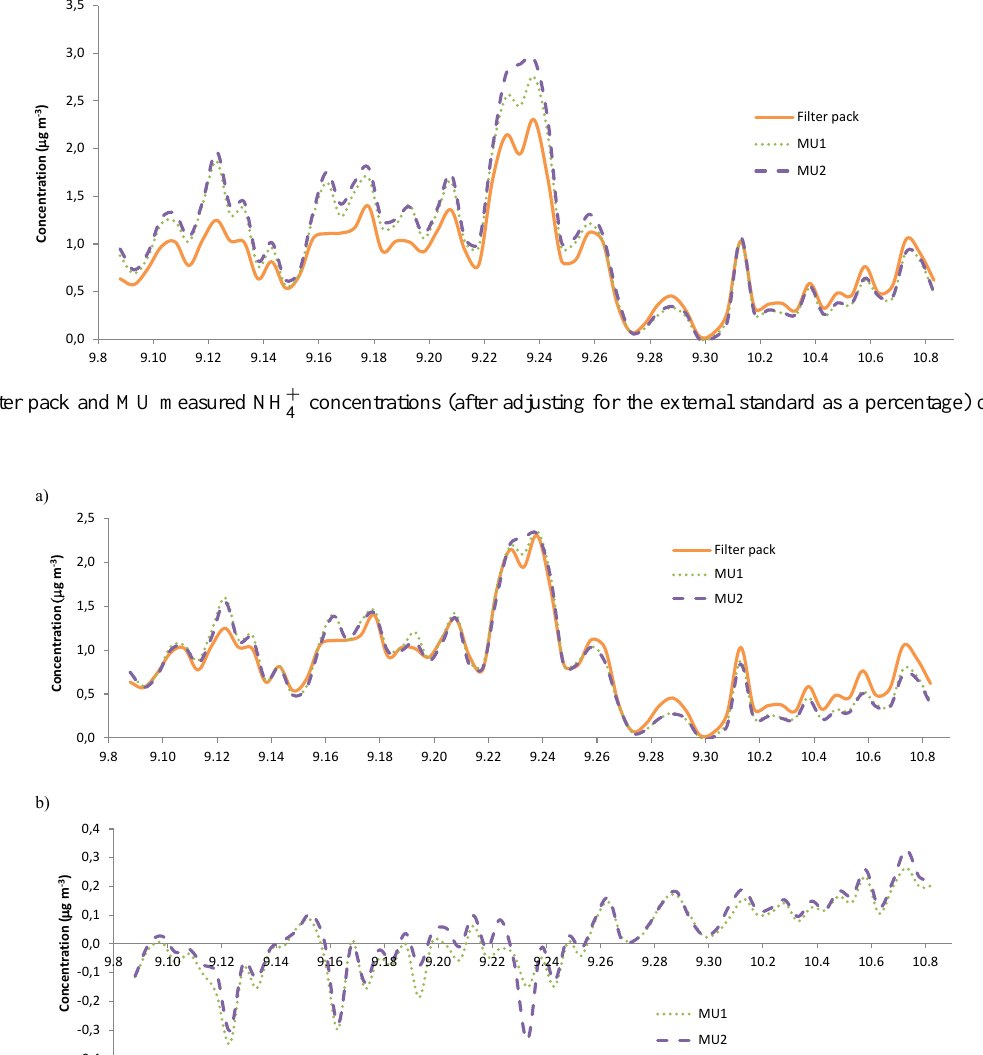
concentrations (unadjusted for the external 4